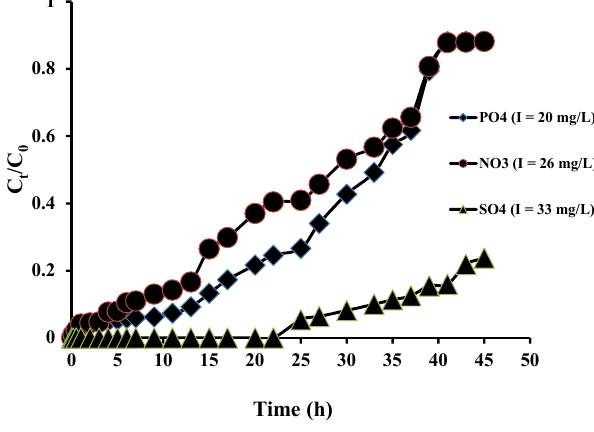
Figure 4. Breakthrough curves for Dowex 21K XLT resin (I is influent concentration).